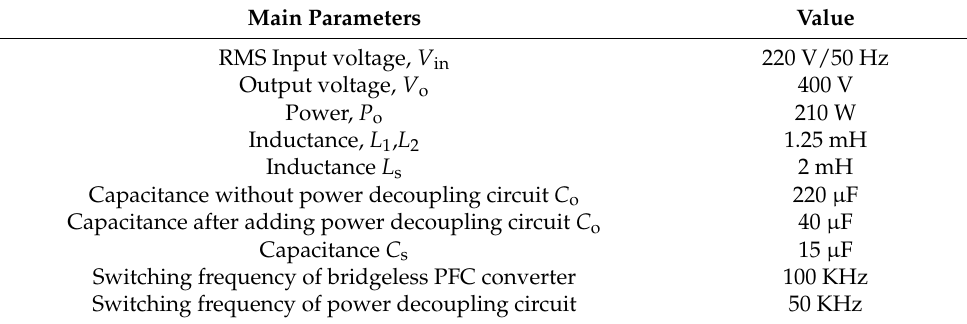
Table 1. Main simulation parameters. Main